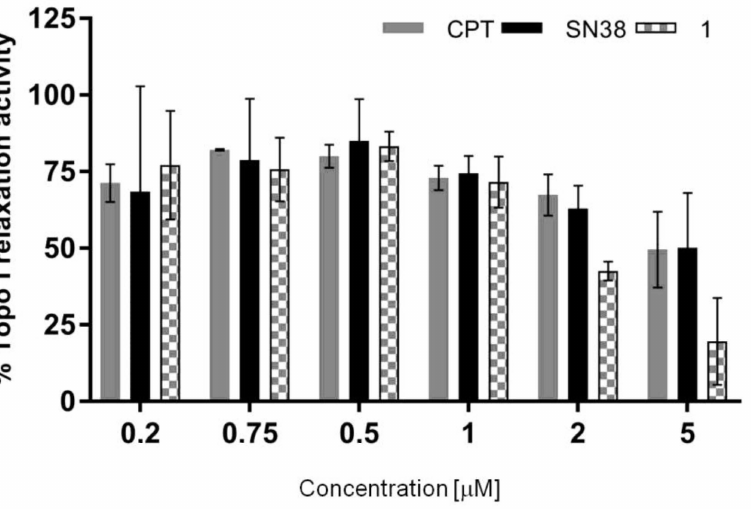
Figure 6. The inhibition of human Topo I relaxation activity with regard to increasing concentrations of CPT, SN38, and new Topo I poison 1 . The mean and SD are presented